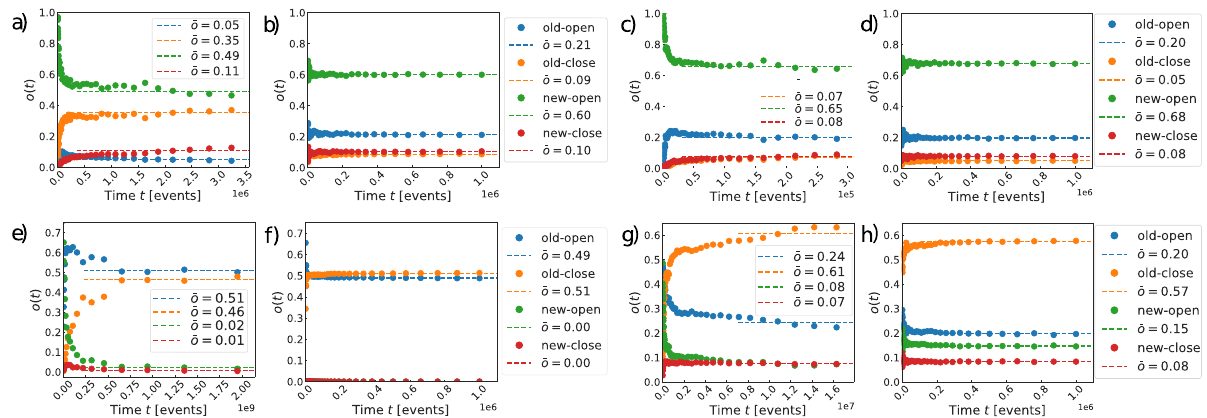
Fig. 6 Dynamics of links formation: empirical data and model predictions. The plot of the empirical data and model results for the fraction of activated links that are: old (i.e., they have been active before) and open (they close no triangle) OO ( t ) (blue markers), old and close (i.e., they close at least one triangle) OC ( t ) (orange markers), new (i.e., they get activated for the fi rst time) and opens NO ( t ) (green markers), and new and close NC ( t ) (red markers). In each case, we show the temporal behaviour (markers), and the asymptotic value (dashed lines, the asymptotic value is reported in the legends). Panels refer to ( a ) American physical society (APS) and ( b ) its model, ( c ) 1-link subsampling of APS and ( d ) the synthetic model, ( e ) the mobile phone network (MPN) dataset and (f) it is corresponding numerical one, and ( g ) the Twitter mentions network TMN dataset with ( h ) the synthetic